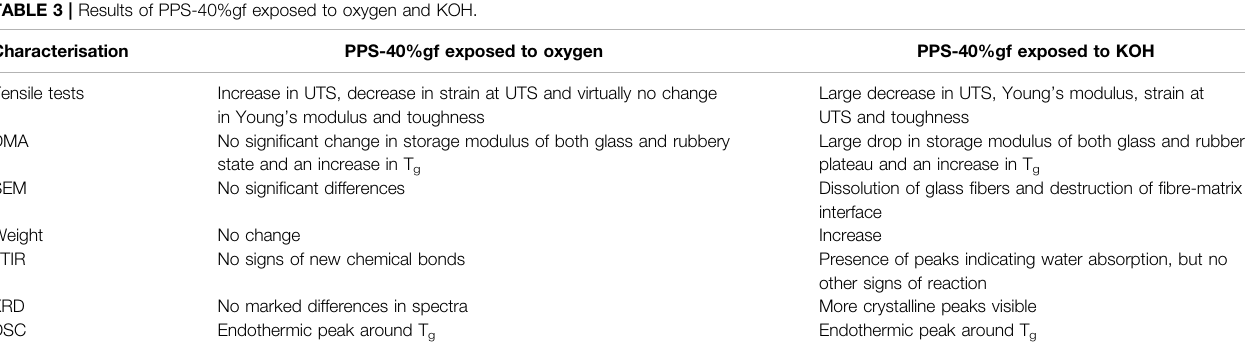
TABLE 3 | Results of PPS-40%gf exposed to oxygen and